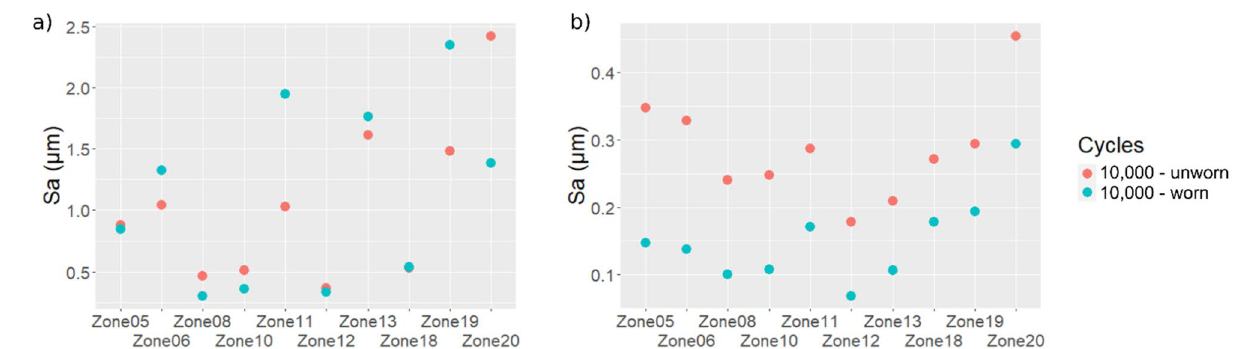
Figure 7. Arithmetic mean deviation (Sa) computed for the 10 selected measurements showing the largest wear traces. The Sa values are computed following the proposed methodology using masks ( a ) without filtering and ( b ) with filtering (high-pass filter with a 25 µm cut-off